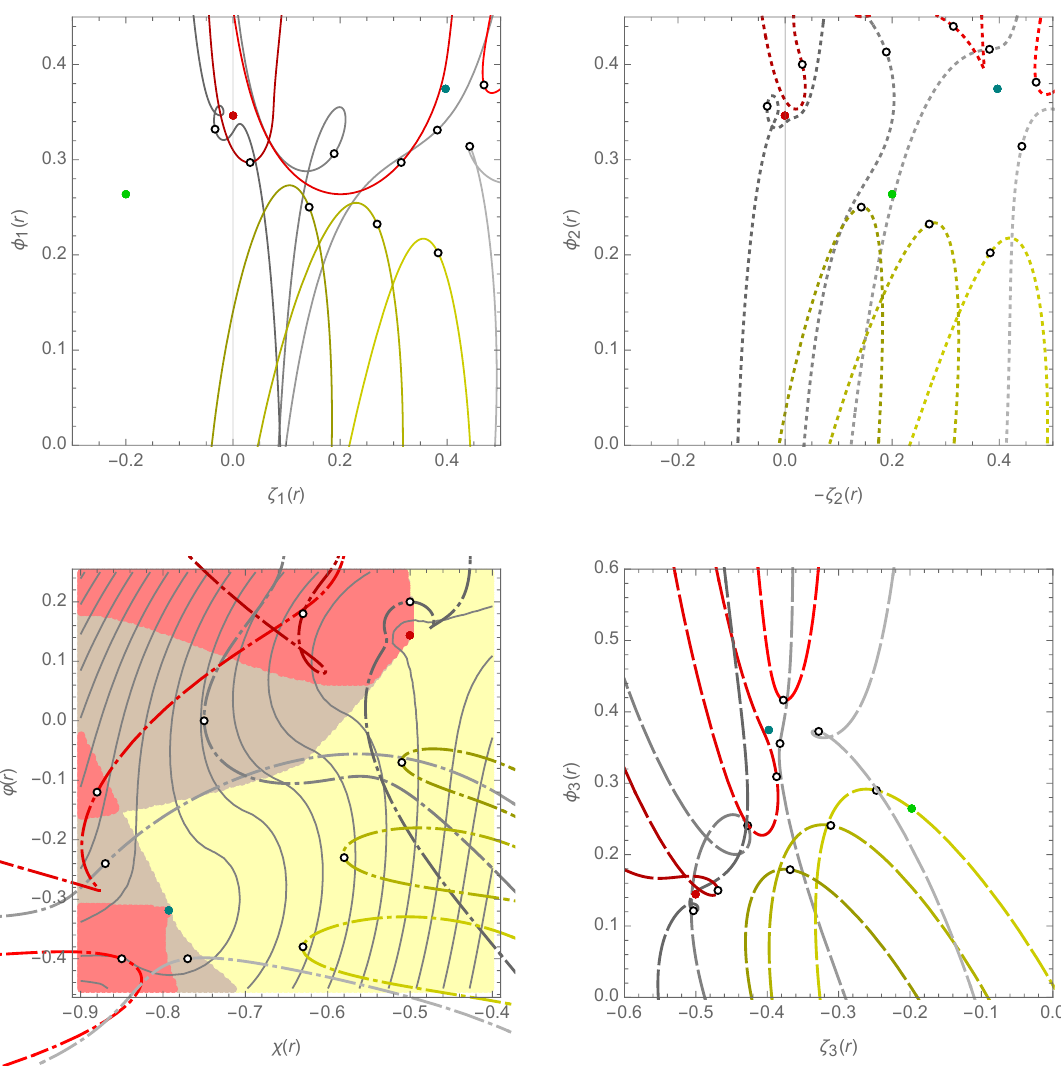
Figure 18. Space of generic N = 1 Janus solutions with SO(3) symmetry. Red and dark green dots represent U(3) and SO(4) critical points while green dot corresponds to G 2 critical